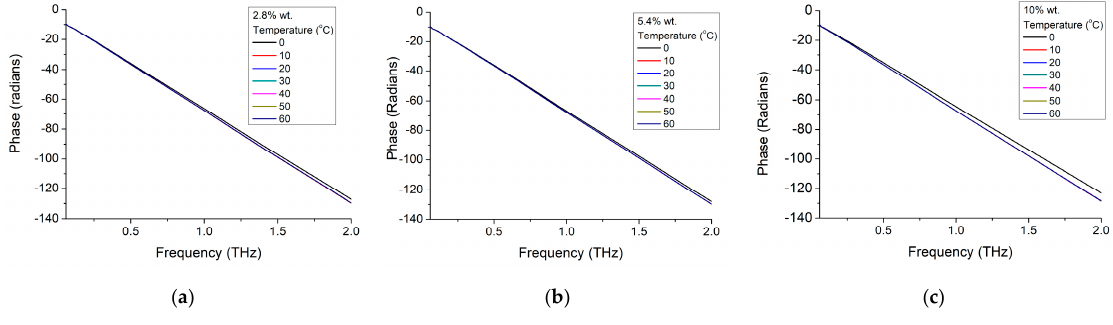
Figure 11. BTO-epoxy losses variation on nanoparticle volume fraction variation at frequencies of ( a ) 400 GHz and ( b ) 1 THz for different temperatures.